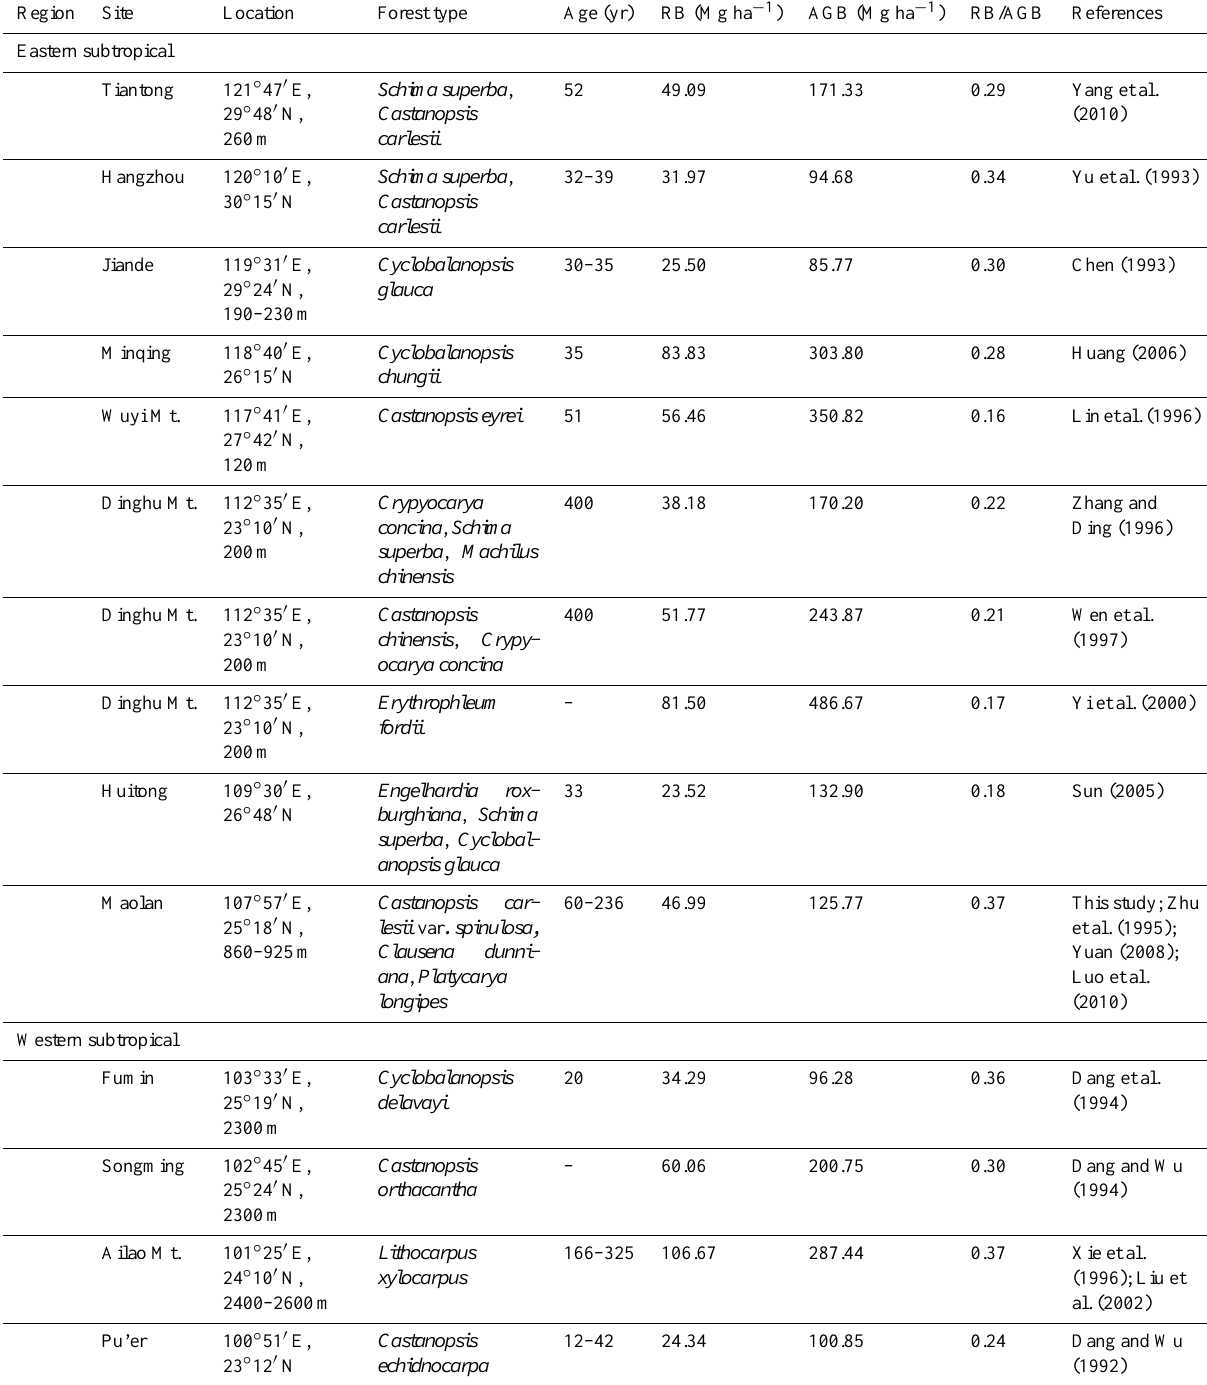
Table 3. Root biomass (RB) and the ratio of RB to aboveground biomass (AGB) of typical evergreen broad-leaved forests in subtropical China.